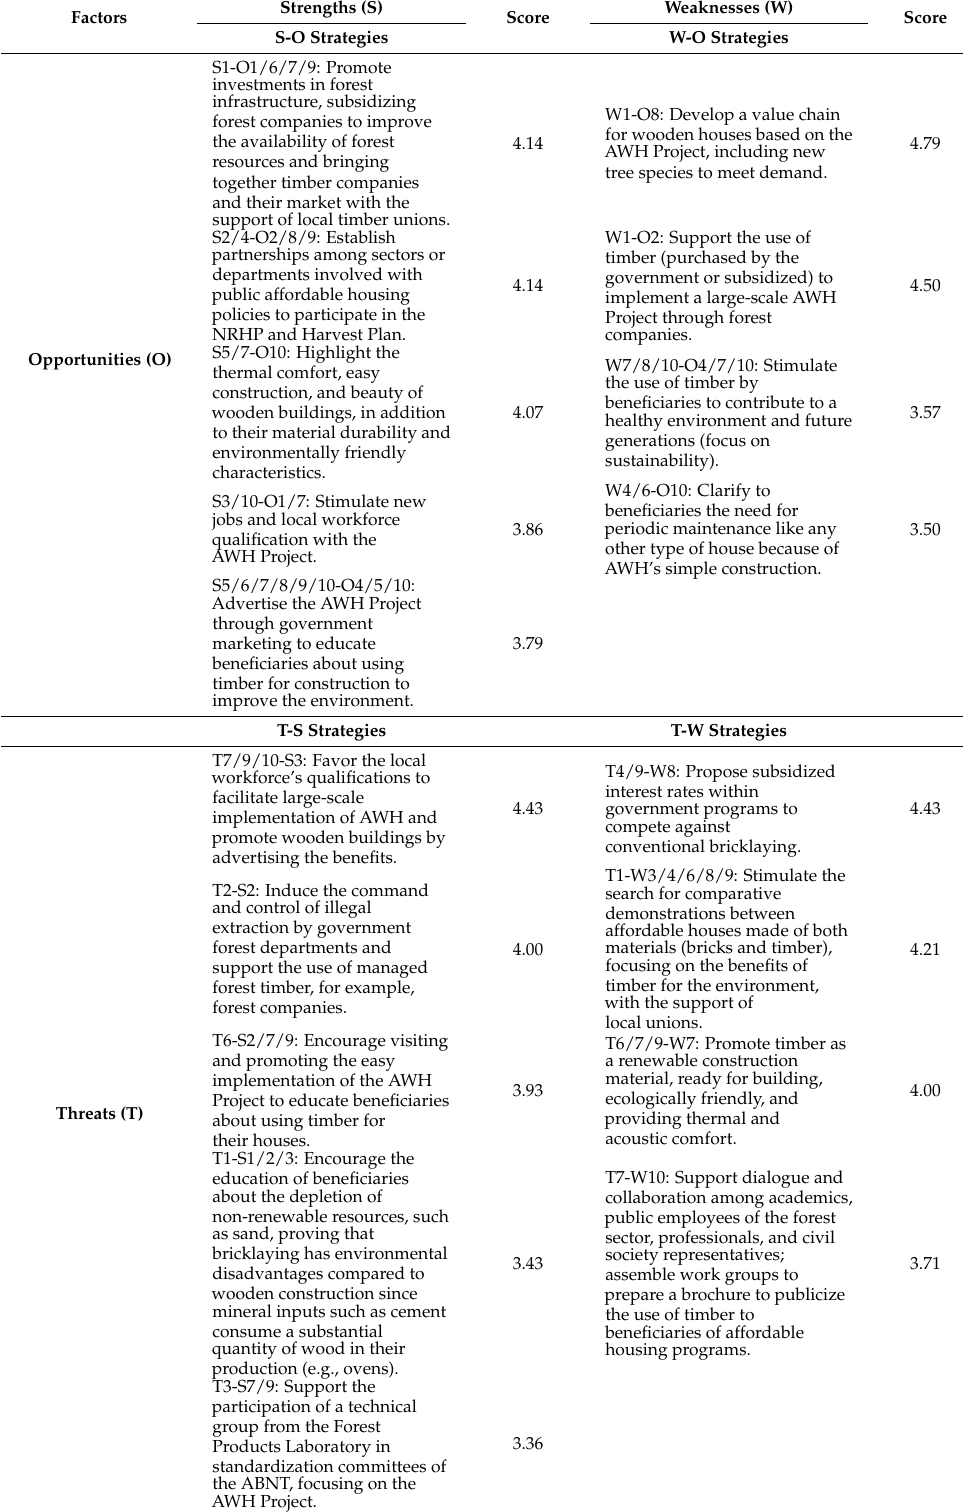
Table 5. Proposed strategies and expert raking scores regarding AWH Project implementation in